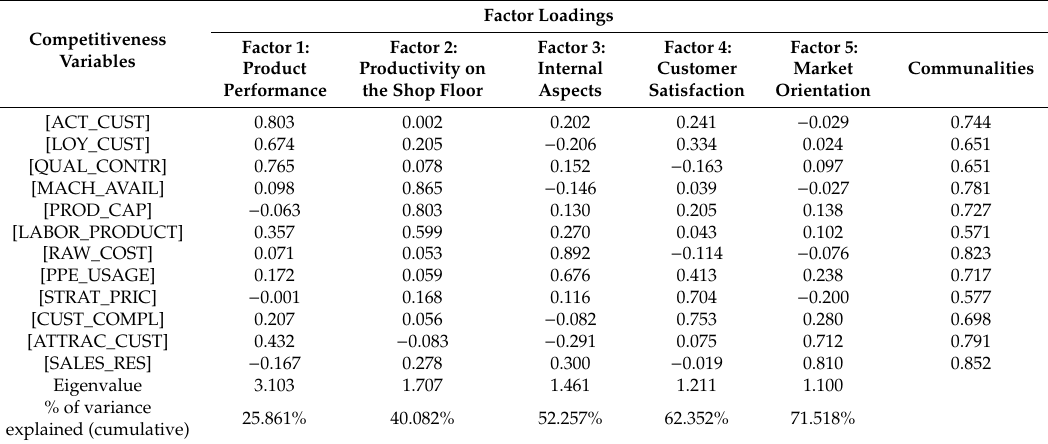
Table 5. Model without the excluded